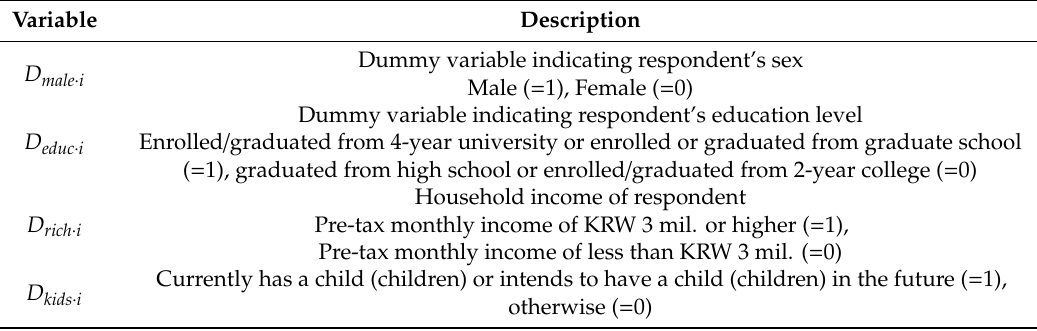
Table 4. Dummy variables indicating the respondent